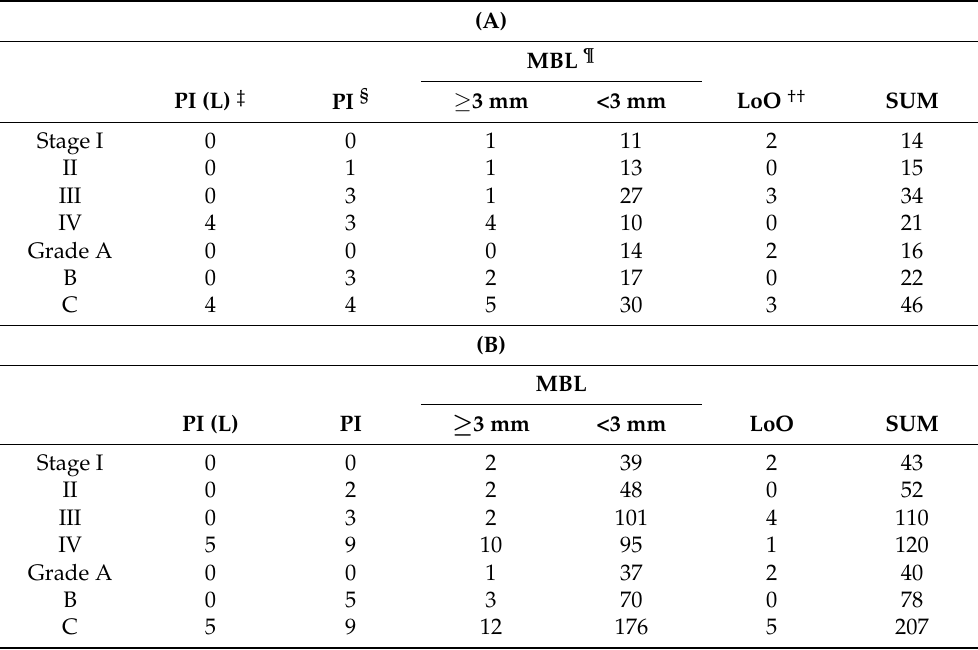
† : Patient level shows the worst outcomes in implant treatment per patient. ‡ : Peri-implantitis (lost). § : Peri- implantitis (surviving). ¶ : Marginal bone loss, MBL (<3 mm) indicates success of implant treatment. †† : Lack of